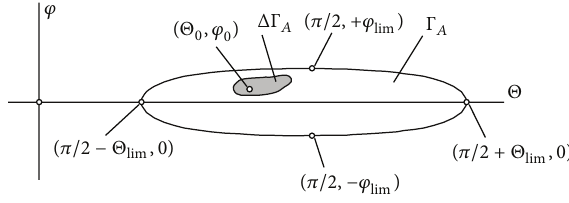
Figure 3: Region Γ 𝐴 in the Θ − 𝜑 coordinate system.